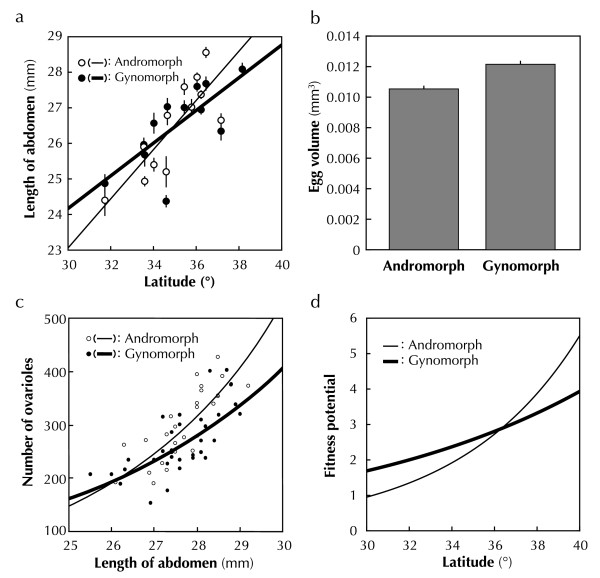
Latitudinal changes in fitness-related traits. (a) The mean length of abdomen increased with latitude (t = 4.618, df = 24, P < 0.001), although no significant effect of morph or interaction between morph and latitude are found (t = 1.244, df = 24, P = 0.227, t = -1.255, df = 24, P = 0.223). The error bars indicate ± S.E. (b) The average volume of mature eggs in andromorphs was significantly smaller than that in gynomorphs (t = 6.158, df = 22, P < 0.001). Error bars indicate ± S.E. (c) The number of ovarioles varied significantly with the abdomen length (GLM: Z = 16.119, df = 59, P < 0.001) and morph (GLM: Z = 2.621, df = 59, P = 0.009). The interaction between morph and abdominal length was also significant (GLM: Z = -2.808, df = 59, P = 0.005). (d) The potential fitness of gynomorphs was higher than that of andromorphs in the south, and the reverse was true in the north, crossing at approximately 36° latitude (equation (3)). The estimated equations are: f(A,l) = 0.0027 exp(0.584 + 0.176l) and f(G,l) = 0.02 exp(0.190 + 0.084l).